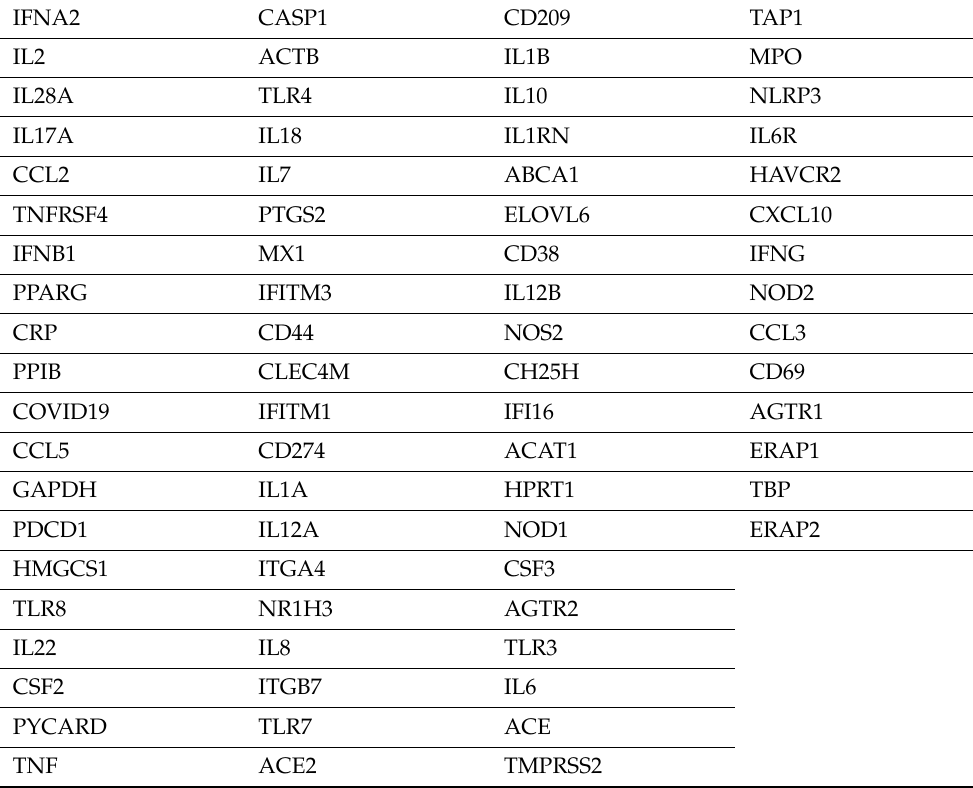
Table 2. Genes involved in the antiviral immune response and housekeeping genes quantified by the QuantiGene Plex